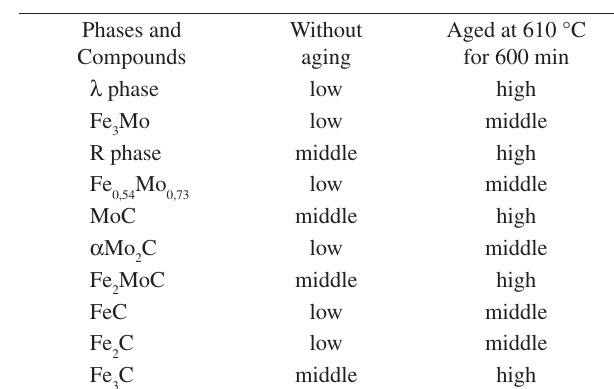
Figure 5. Diffractogram of alloy containing 11 wt. (%) Mo, solution treated at 1250 °C, after hot rolling, aged at 610 °C for 600 minutes. Table 3. Precipitates identified by X-ray diffractometry for alloys containing 11% Mo, hot rolled, solution treated at 1200 °C, without aging and aged at 610 °C for 600 minutes, classified as high, middle or